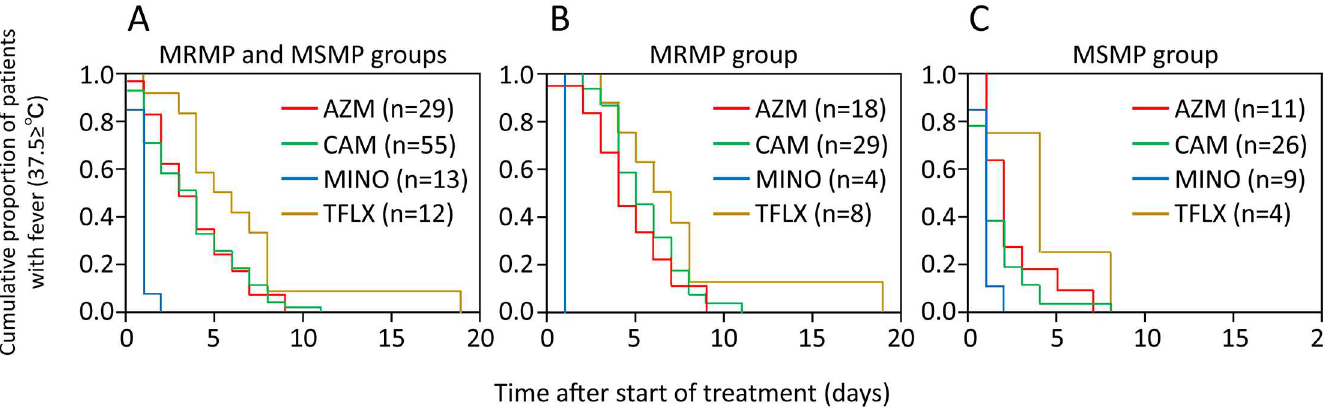
Fig 1. Durations of fever following commencement of treatment for pneumonia due to MRMP and MSMP by azithromycin, clarithromycin, minocycline and tosufloxacin. Kaplan–Meiercurves showinga comparisonof times taken for body temperature to return to < 37.5˚Camong patients with (A) MRMP and MSMP (log-ranktest, P < 0.0001), (B) MRMP (log-ranktest, P < 0.0001) and (C) MSMP (log-ranktest, P = 0.0162).